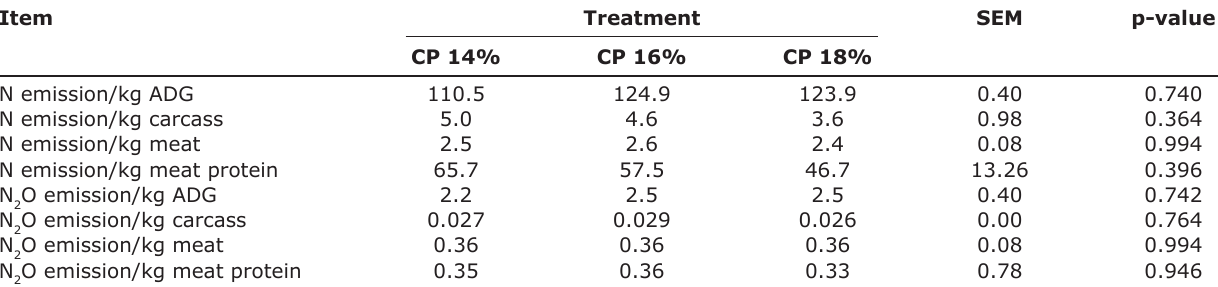
Table-6: Nitrous oxide emissions related to body weight gain and meat production.